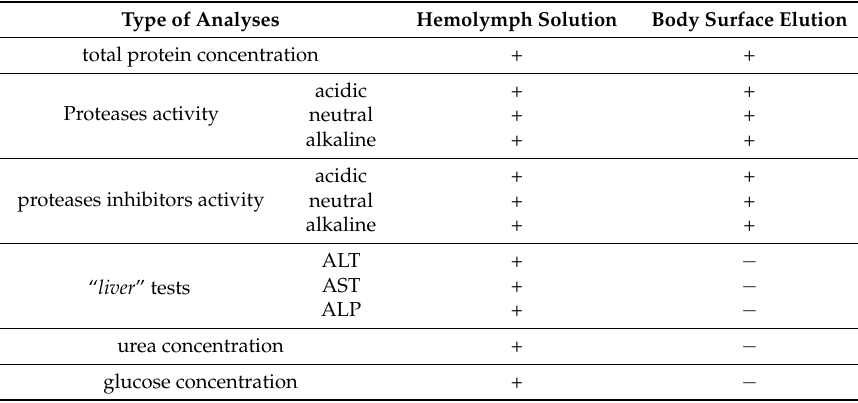
Table 3. Comparison of methodologies of rapid biochemical analyses that are legitimate to use on biological materials obtained from insects. Type of Analyses Hemolymph Solution Body Surface Elution total protein concentration + + acidic Proteases activity